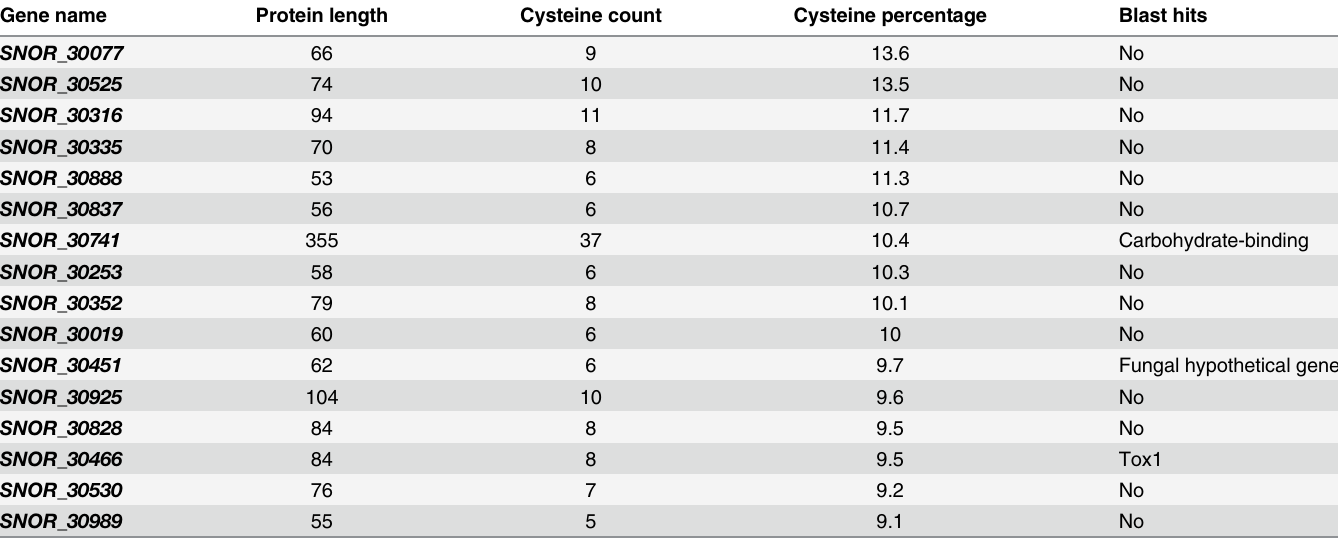
Table 5. Summary of cysteine-rich protein-products of previously unannotated genes in P . nodorum SN15. Novel cysteine-rich annotations have few BLAST hits and include potential effector candidate genes e.g. SNOG_30451 - a degraded and truncated homolog of Tox1 .